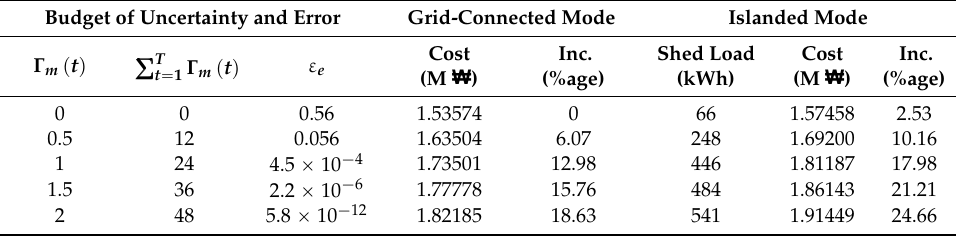
Table 3. Performance in islanded mode with single source of uncertainty. Budget of Uncertainty and